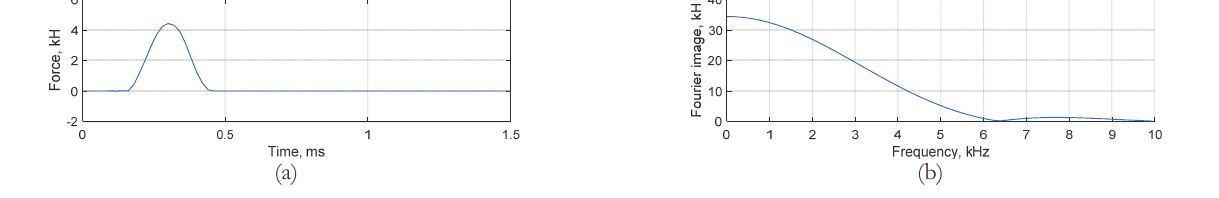
Figure 4: Impulse load: (a) – force evolution. (b) – Fourier transform.